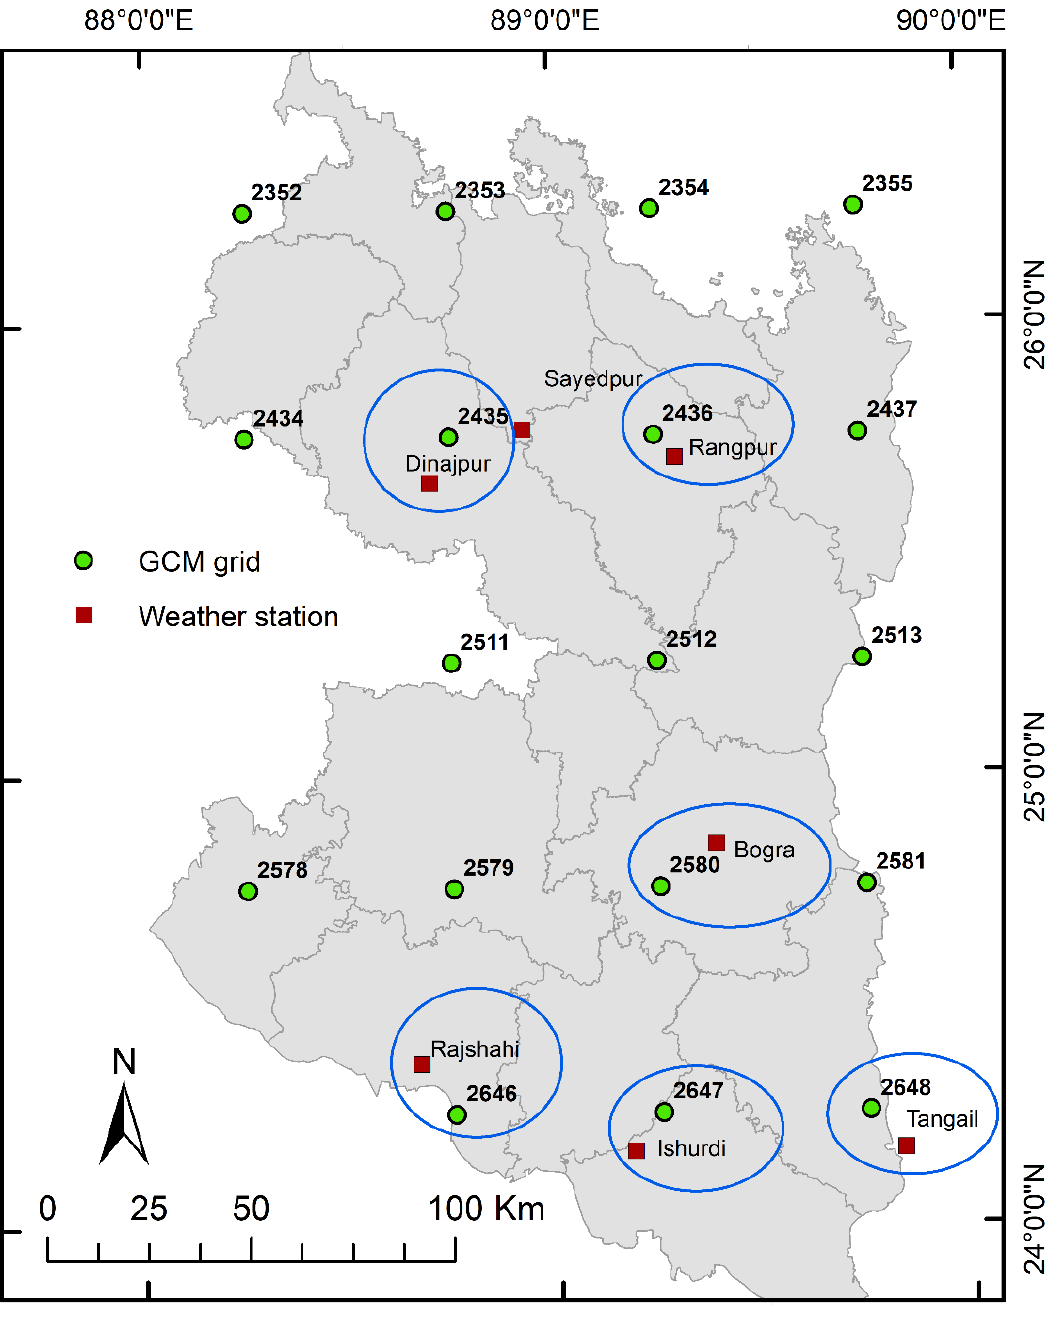
Figure 3. Global climate model (GCM) grids (green dot) and metrological stations (red square) in the northwest region of Bangladesh. Selected GCM grids are circled blue, along with nearest meteorological station. The numbers show the grid point numbers in the Zheng et al. [30] scaling factor set.